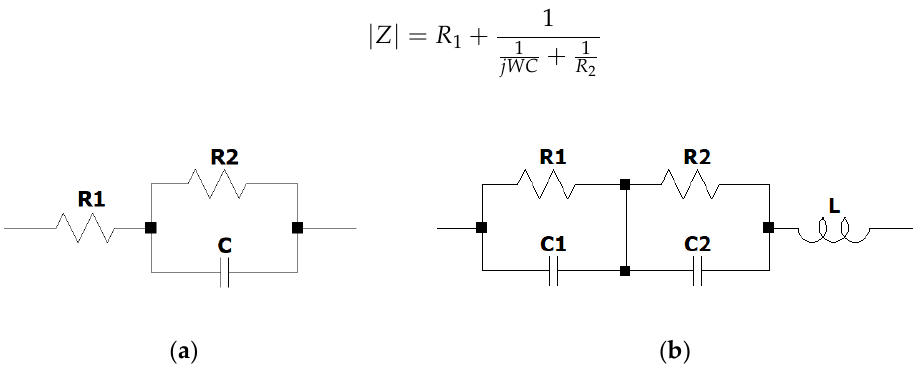
Figure 4. Equivalent circuit of the sensor ( a ) not including glycerin and ( b ) including glycerin .